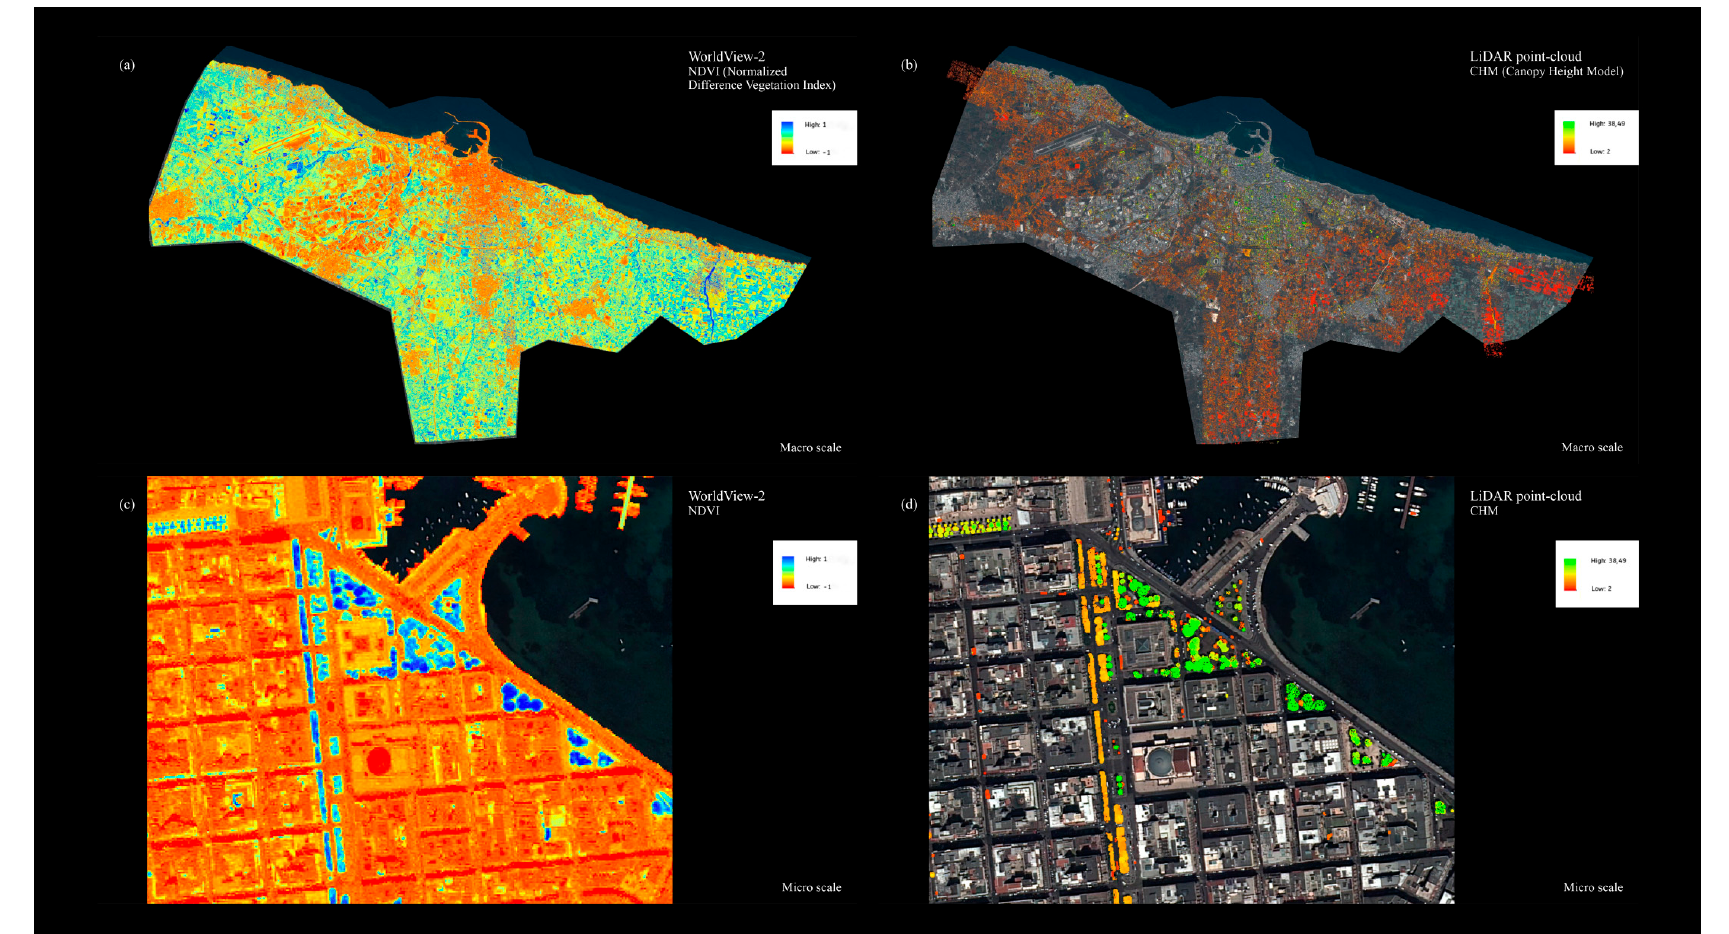
Figure 1. Examples of satellite imagery and LiDAR point-cloud data: ( a ) WorldView-2 NDVI at city-regional level, ( b ) LiDAR point-cloud Canopy Height Model (CHM) at city- regional level, ( c ) WorldView-2 NDVI at local-/district-city level, ( d ) LiDAR point-cloud CHM local-/district-city level.